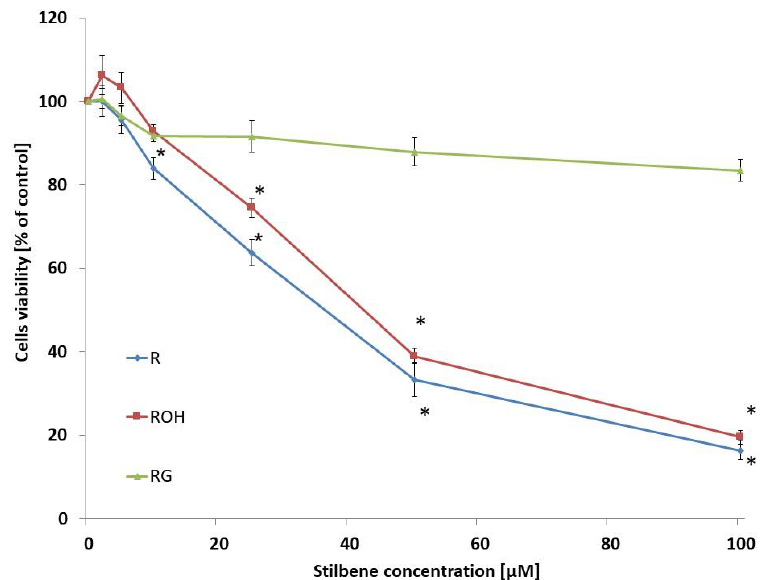
Figure 2. Effect of resveratrol (R), piceatannol (ROH), and piceid (RG) on MCF-7 viability. Cell viability was estimated with the MTT test and analysed after 48 h of treatment of the MCF-7 cells